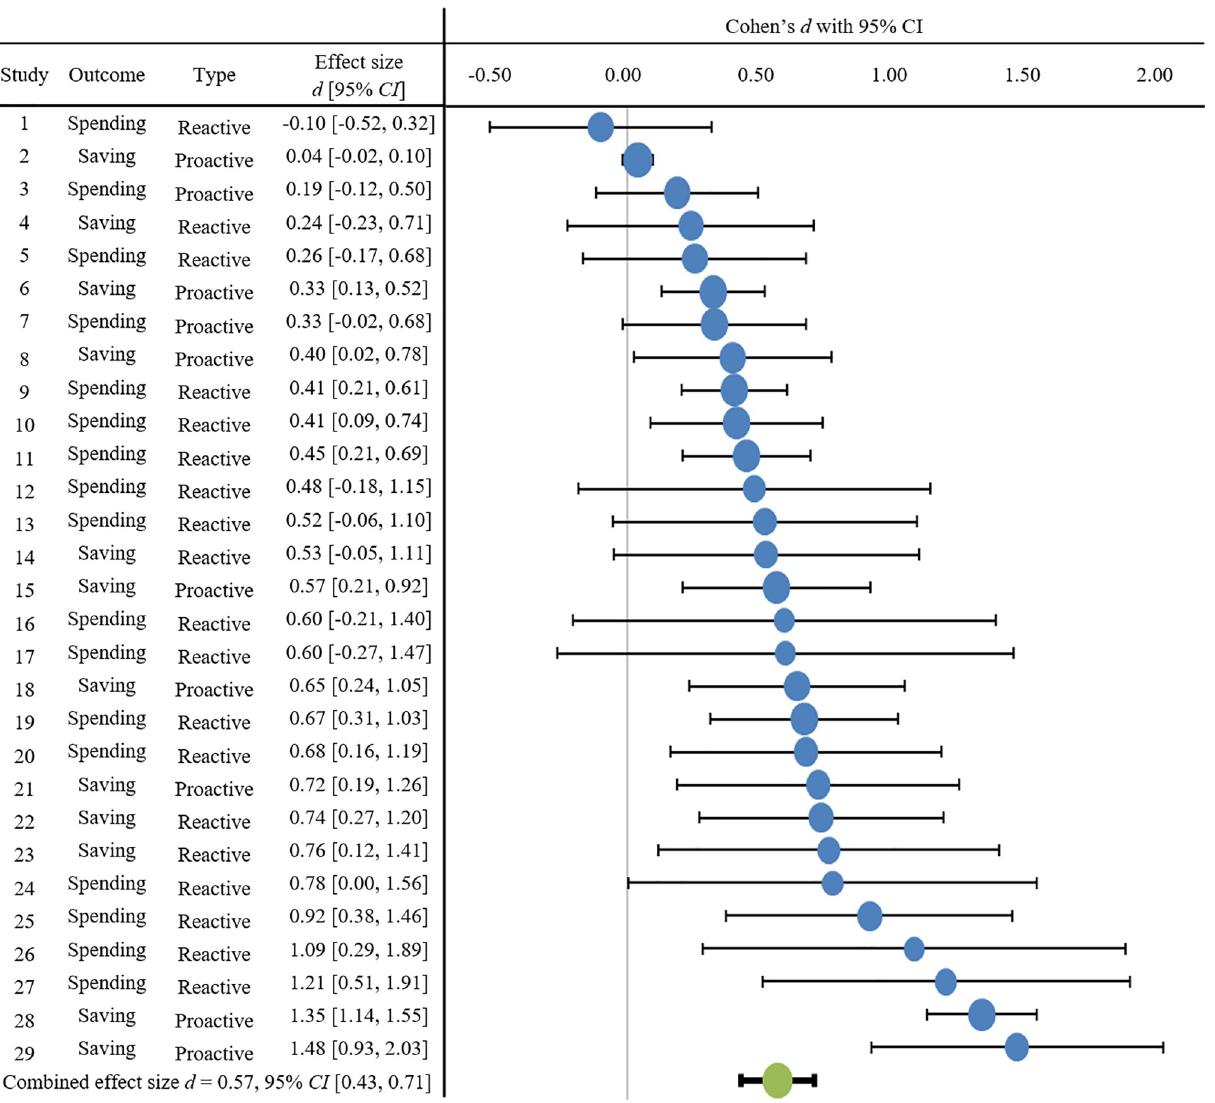
Fig 2. Forest plot of strategy use effect size by study. Each line represents one observation. The position of the bubble depicts the effect size. The size of the bubble represents the weight of that individual study on the overall average effect size, whereby studies with larger sample sizes are weighed more and are represented with larger bubbles. The green bubble represents the weighted combined effect size. The bars represent the 95% confidence interval. Outcome refers to whether the purpose of the strategy is to reduce spending (Spend) or increase saving (Save). Type refers to whether the strategy is proactive (PRO) or reactive (RE). Refer to Table 1 for strategy